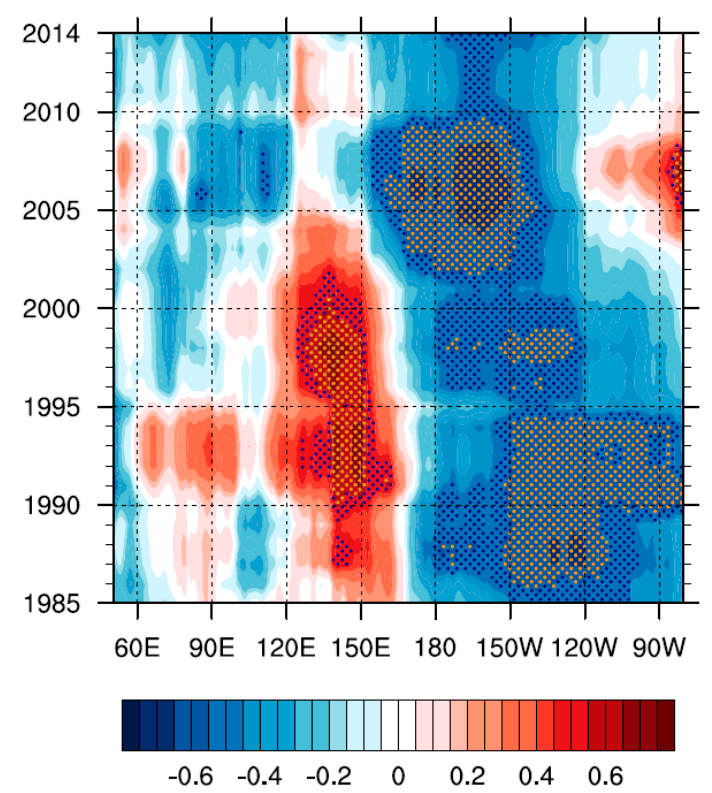
Figure 2. Evolution of tropical (5 ◦ S–15 ◦ N-averaged) JJA SST anomalies obtained by a 13-year sliding correlation on the JFM SHI index. Black (yellow) dots indicate significant correlation coefficients above the 90% (95%) confidence level based on the two-sided Student’s t -test.